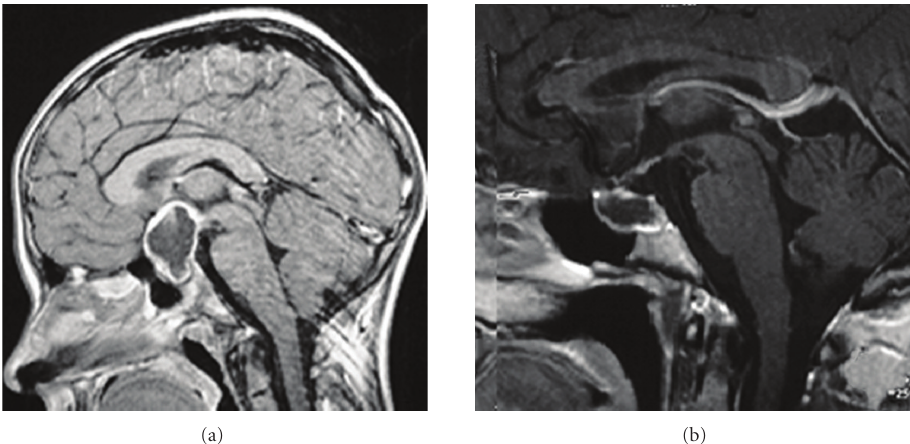
Figure 1: Obesity and daytime sleepiness in relation to the localization of craniopharyngioma. The patient whose preoperative MRI (a) showed a large tumor extending to the suprasellar region and infiltrating the hypothalamus developed severe daytime sleepiness and, consequently, obesity (BMI: +14 SD [4]). The patient with a childhood craniopharyngioma of intrasellar localization seen in Figure 1(b) maintained normal weight (BMI: +1 SD [4]) and developed no daytime sleepiness.